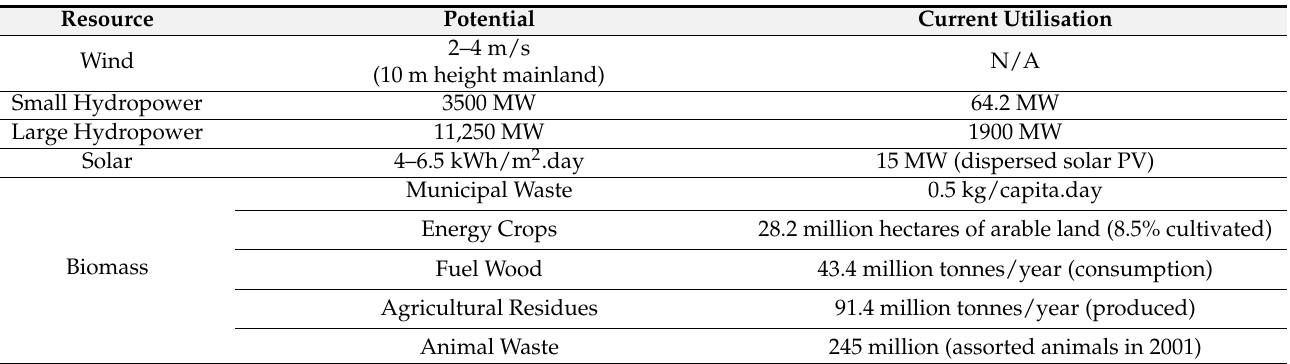
Table 4. Renewable energy potential. Data taken from